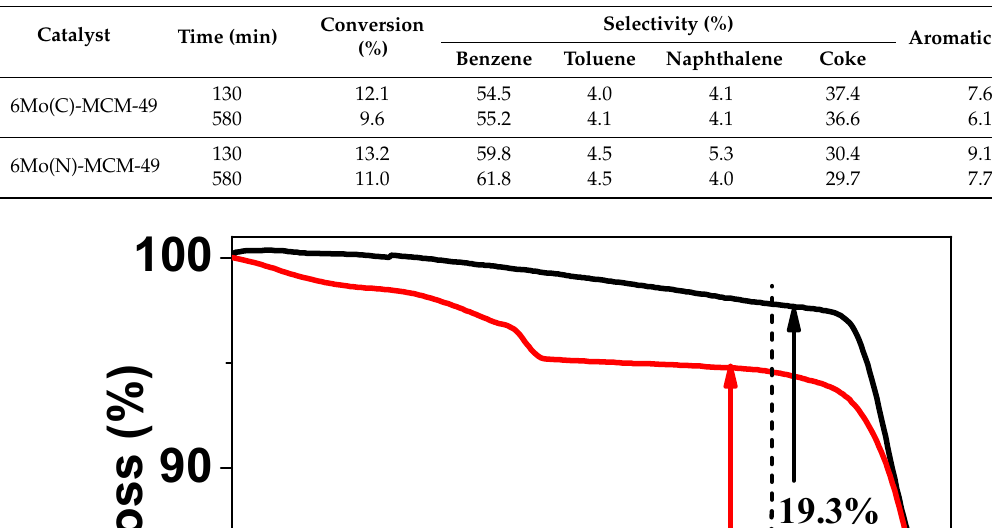
Table 1. Catalytic results of methane non-oxidative aromatization over various catalysts.